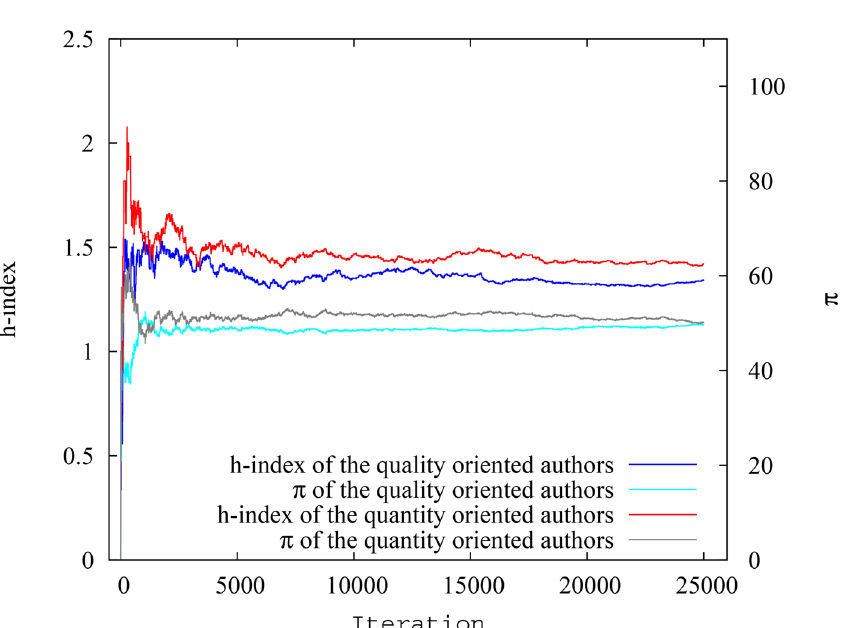
Fig 13. Variation of average h-index and pagerank-index for quantity oriented authors and quality oriented authors at each timestep in scenario 3. The difference between groups is much smaller when pagerank-index is used.